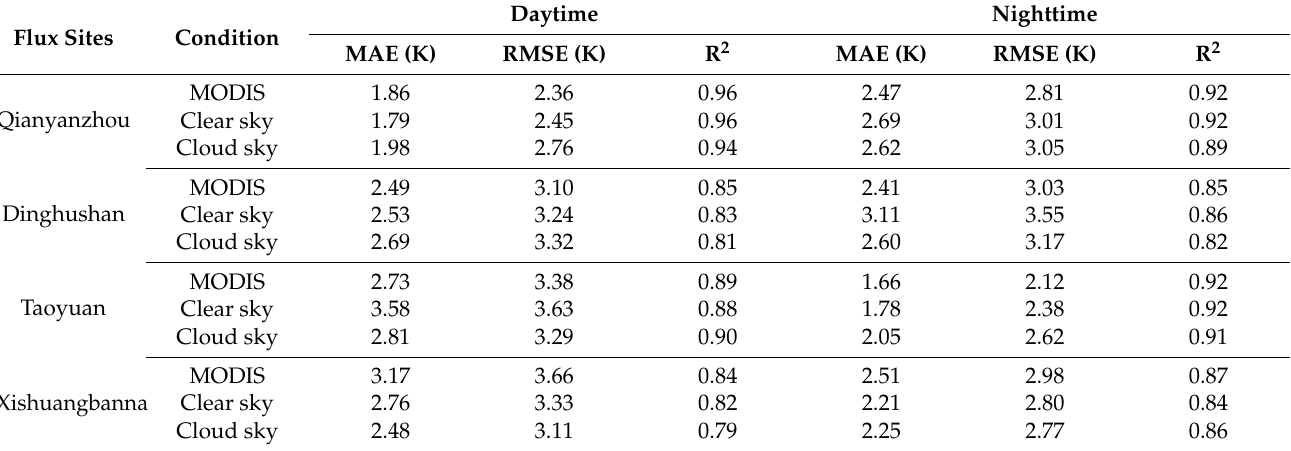
Table 2. Statistics of MODIS LST and MLP-GTWR LST cor against in situ LST for daytime and nighttime at the four flux